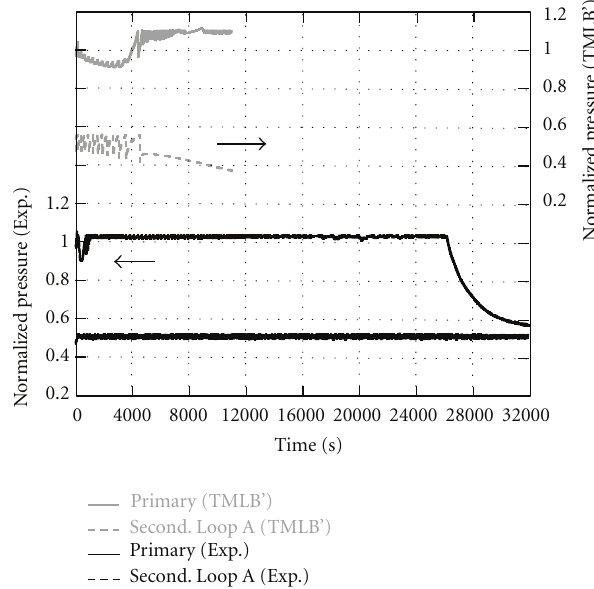
Figure 24: Comparison with TMLB’ scenario test results for primary and secondary pressures in loop with